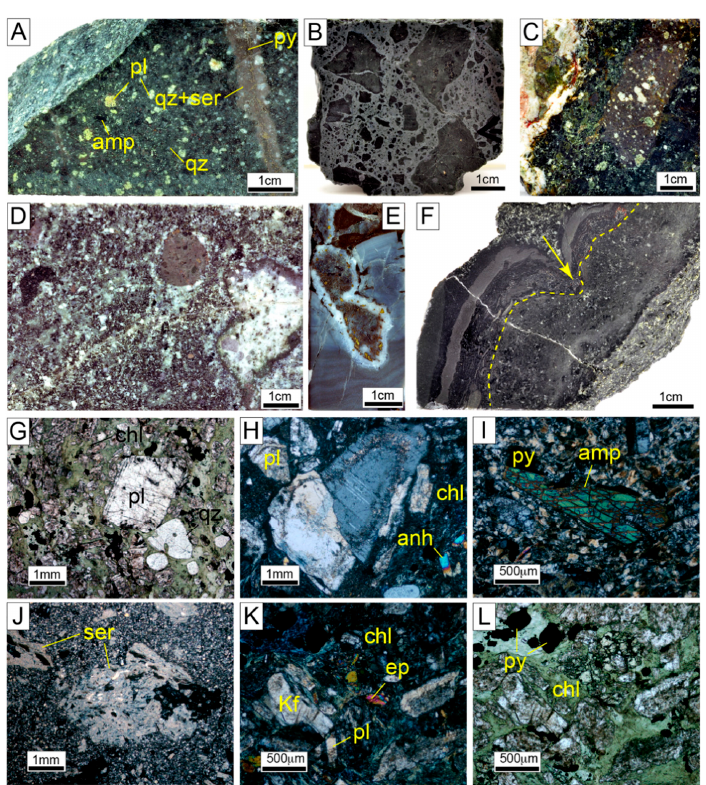
Figure 4. Hand sample photographs ( A – F ) and thin section photomicrographs (transmitted light, plain polarized light: ( G , L ); crossed polars: ( H – K )) illustrating textures and mineralogy of the hosting volcanic, volcaniclastic and volcano-sedimentary rocks in the Romero deposit. ( A ) Andesite sample with a massive lithofacies and an aphanitic, porphyritic texture given by phenocrysts of plagioclase, amphibole and scarce quartz; ( B ) matrix-rich andesitic hyaloclastite with dark-rimmed vitriclasts showing curviplanar margins and depicting clast-in-matrix and local jigsaw-fit and tiny normal joints; ( C ) in this breccia of andesitic composition, all clasts show similar aphanitic, porphyritic and amygdaloidal textures; however, they have been variably silicified and chloritized, and as a result, their color is variable from clast to clast. The conspicuously irregular shapes and the monomict character of the clasts along with the poor sorting and the low proportion of matrix suggest that it is an autoclastic breccia; ( D ) in this matrix-rich breccia, rounded to sub-angular clasts of variable color are embedded in a crystal-rich matrix. Both the matrix and the clasts show extensive silicification; the relatively abundant crystal phenocrysts suggest a dacitic composition; ( E ) in this sample, interpreted as a peperite, islands of a pale green volcanic rock (magmatic component) crosscut the bedding of a silicified very-fine grained sedimentary rock; the volcanic component is wrapped by a white quartz rim enriched in pyrite and chalcopyrite; ( F ) thin beds of gray mud (ash) alternate with beds of parallelly oriented, sand-sized black glass wisps. The bedding deforms around an andesitic angular clast some centimeters across, drawing a sag structure in which the most conspicuous aspects are the asymmetric folding of the gray mud layers and the thinning of the upper (in the sense indicated by the arrow) layer; ( G ) aphanitic, plagioclase- and quartz-phyric andesite, of which matrixes have been pervasively altered to chlorite; quartz phenocrysts show embayed margins and voids filled with the chloritized material of the groundmass; ( H ) zoned plagioclase crystals embedded in a fine grained, chloritized groundmass which also contains some small anhydrite crystals; ( I ) fresh amphibole phenocryst embedded in fine-grained groundmass composed of abundant plagioclase; ( J ) glomerule composed of tabular crystals pseudomorphically altered to sericite; ( K ) the porphyritic texture in this andesite is given by plagioclase and K-feldspar phenocrysts locally altered to sericite; the groundmass is pervasively altered to chlorite and epidote; ( L ) same image as in ( K ), in plane polarized light. Abbreviations: amp = amphibole; anh = anhydrite; chl = chlorite; ep = epidote; Kf = K-feldspar; pl = plagioclase; py = pyrite; qz = quartz; ser =